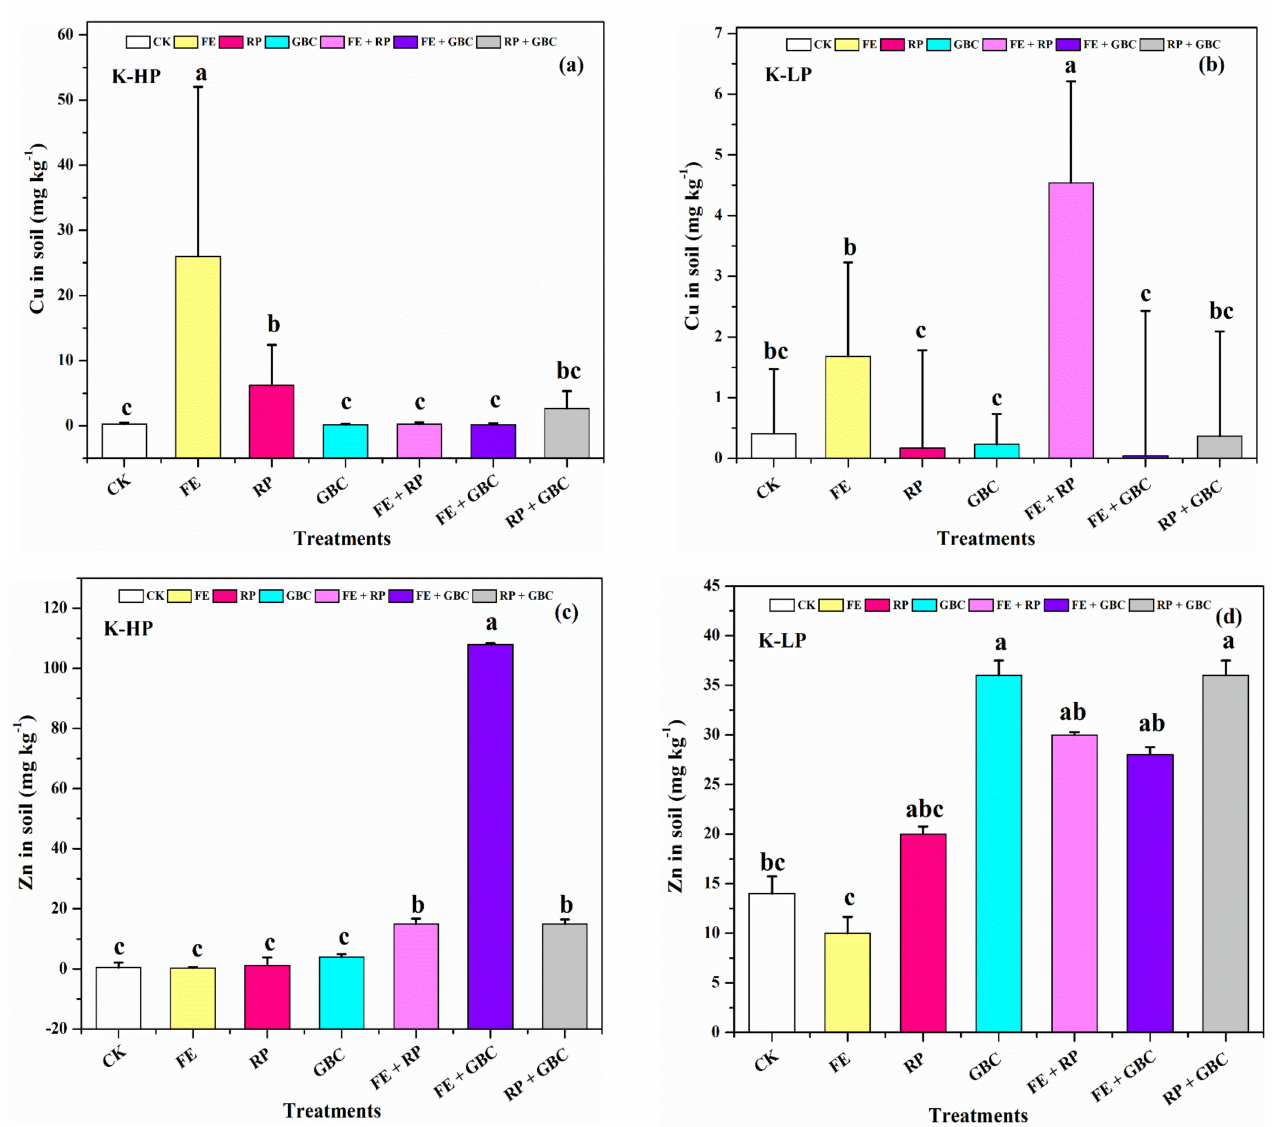
Figure 5. Influence of additives on Cu in ( a ) in K-HP soil and ( b ) H-LP soil; influence of additives on Zn, ( c ) in K-HP soil, and ( d ) in H-LP soil. The values in a given column followed by the same letter are statistically not significantly ( p < 0.05) using Tukey’s HSD